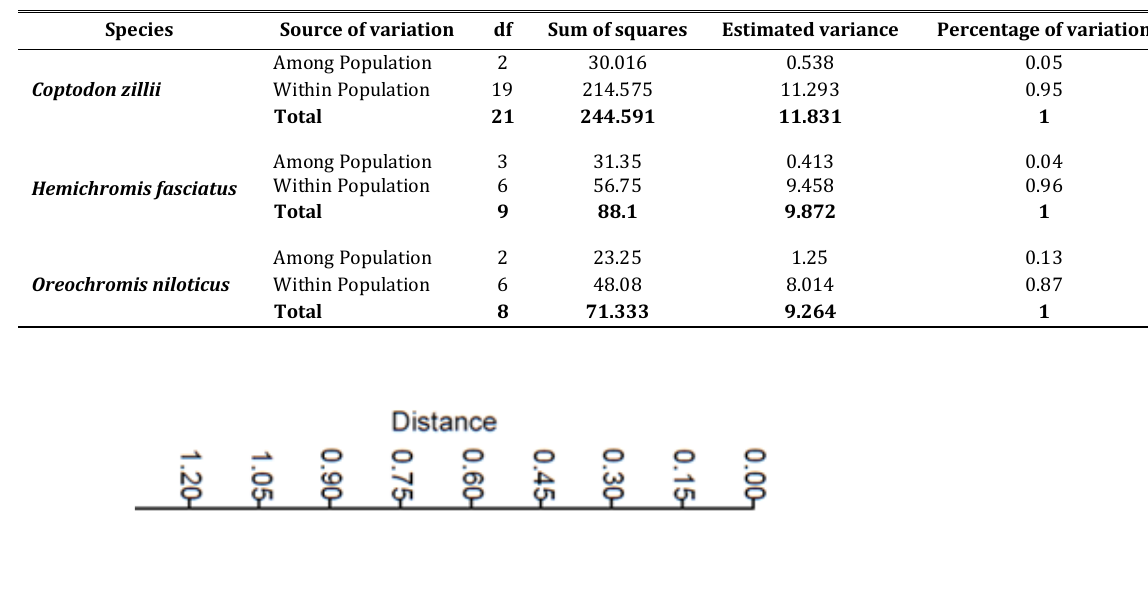
Table 4. Summary of analysis of molecular variance (AMOVA) among and within cichlid populations